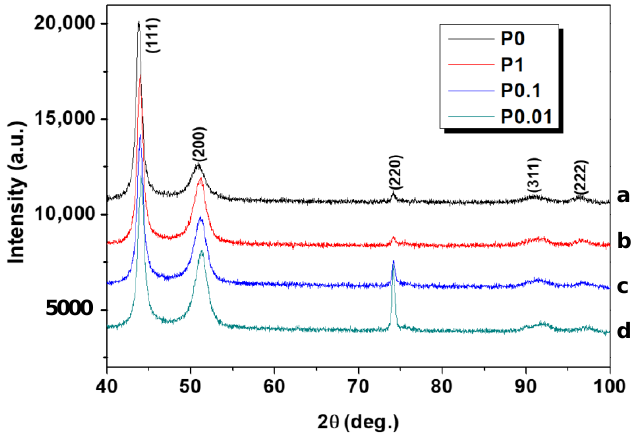
Figure 4. XRD patterns of FeNi shielding coatings: (a) P0, (b) P1, (c) P0.1, and (d) P0.01. Table 2. Crystal structure parameters of FeNi shielding coatings obtained with different electrodeposition modes. Shielding Coating